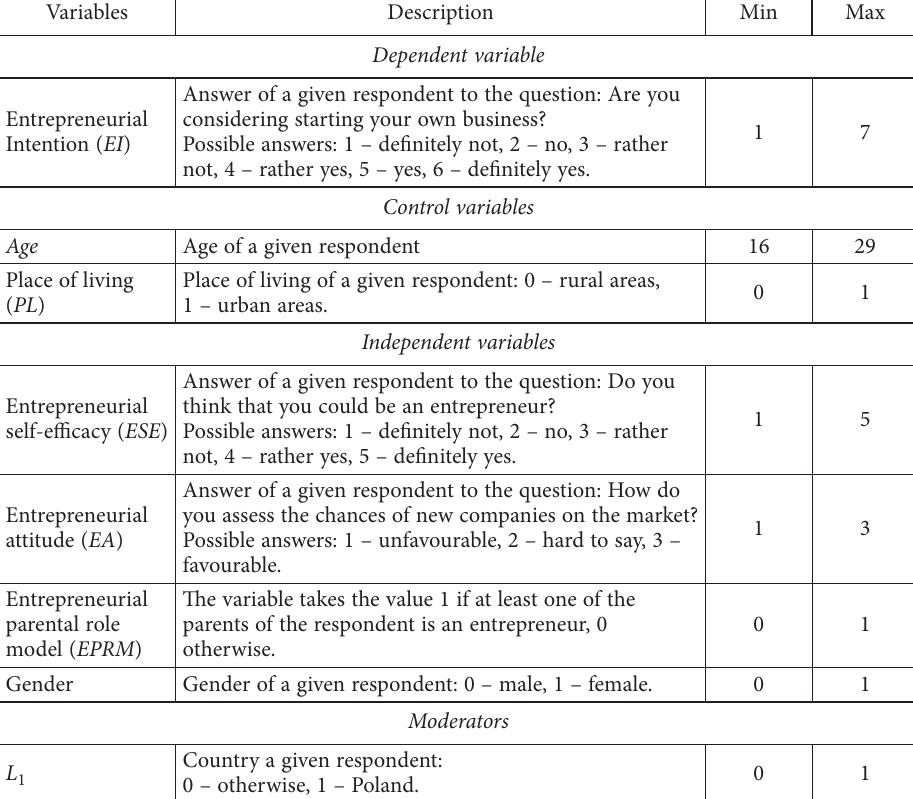
Table 2. Description of variables used in the hierarchical multiple OLS regression